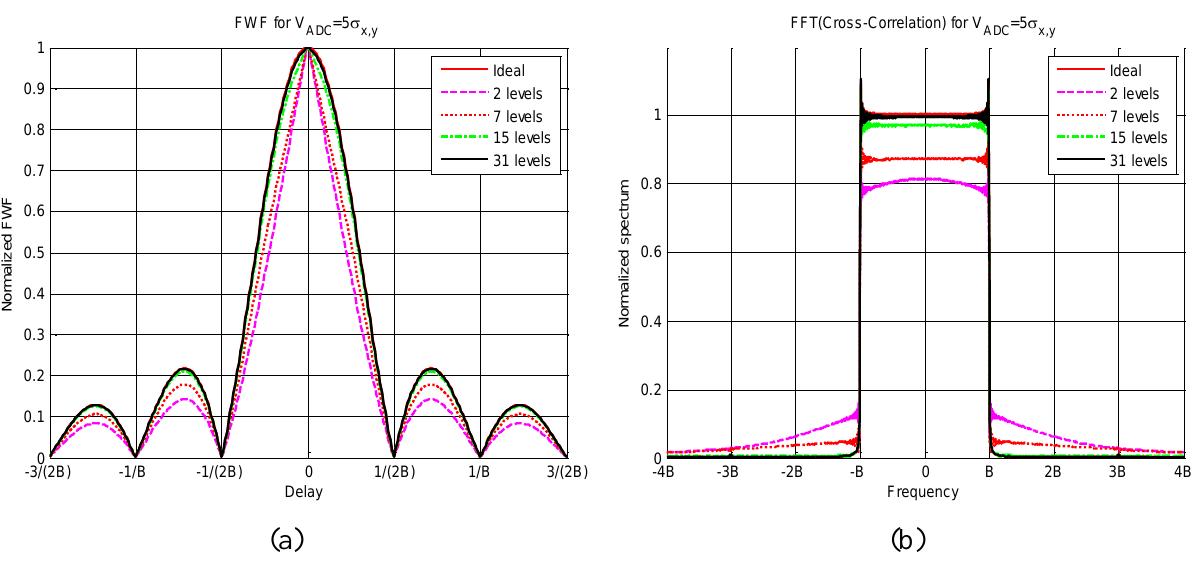
= 5σ and different ADC x,y